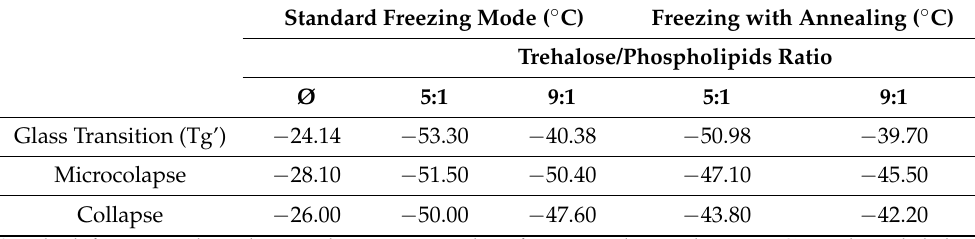
Table 3. Determination of the Tg’ and collapse temperature of LCFL-PTX/DXR at different trehalose concentrations and freezing